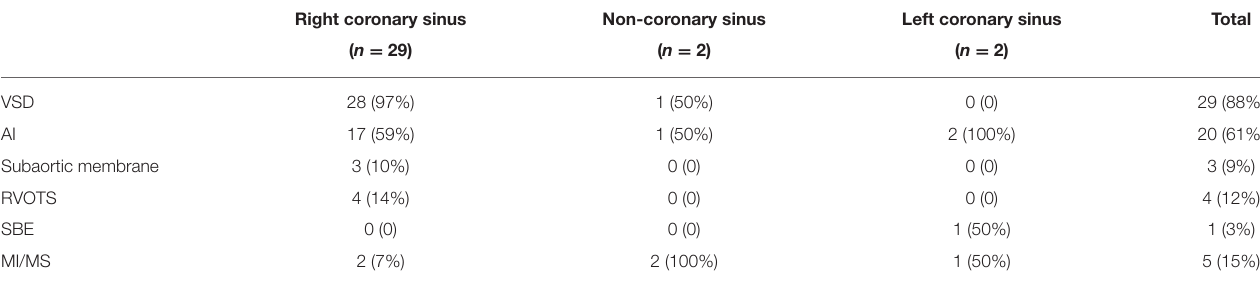
TABLE 2 | Cardiac lesions accompanied by an unruptured sinus of Valsalva aneurysm (USVA). Right coronary sinus Non-coronary sinus Left coronary sinus Total